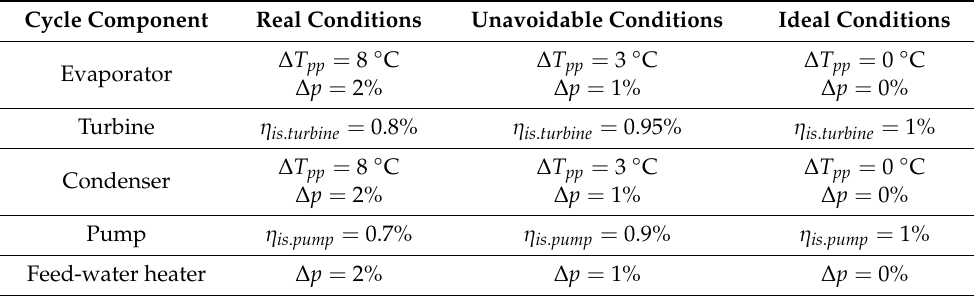
Table 2. The assumed conditions for performing an advanced exergy analysis under real, unavoidable and ideal conditions